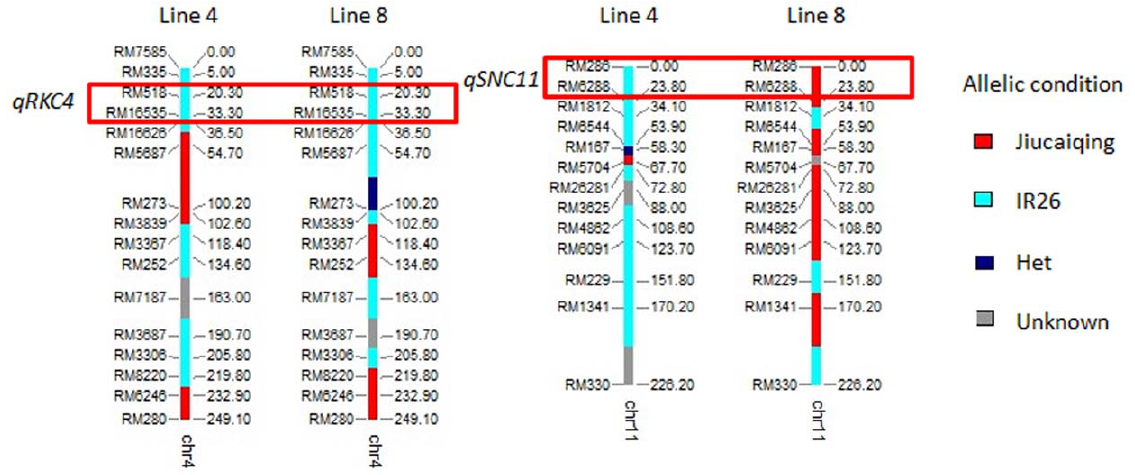
Figure 4. Graphical representation of the genotype of chromosomes located QTLs for lines 4 and 8.